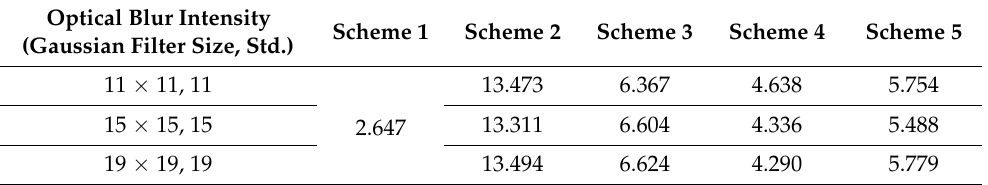
Table 4. Comparison of finger-vein recognition error (EER) with and without motion and optical blur application and restoration in SDU-DB (unit: %). Optical Blur Intensity (Gaussian Filter Size, Std.)